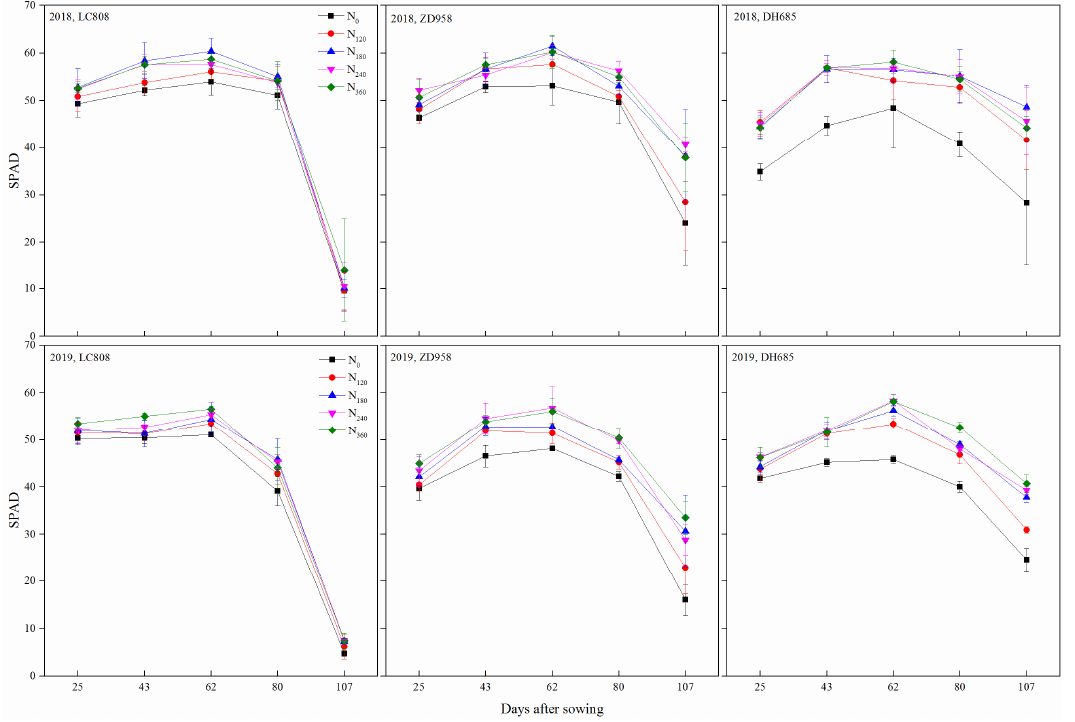
Figure 3. Dynamic of SPAD in different stay-green types of maize under the different N levels. Error bars indicate the SD.